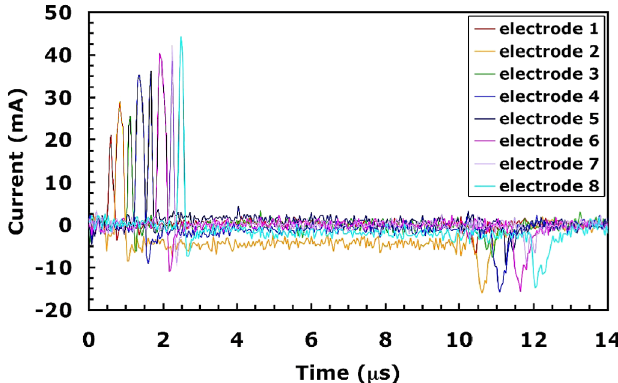
FIG. 7. (Color) Electron cloud diagnostic signals as a function of time.